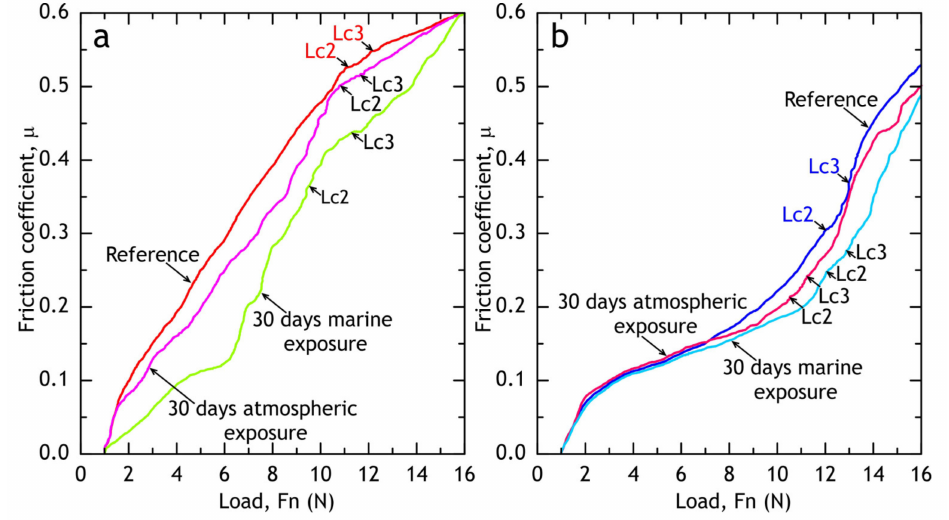
Figure 23. PEO ( a ) and composite ( b ) coatings’ friction coe ffi cients after atmospheric exposure and marine